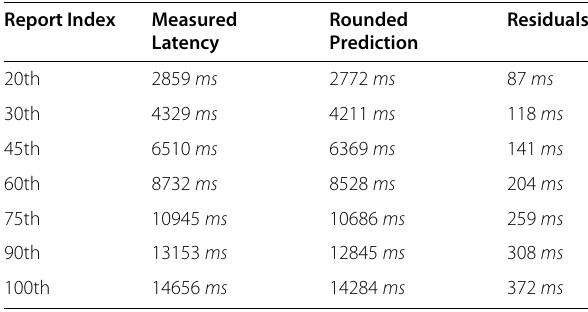
Table 3 Validation of the FIFS Uploading Latency Model by Using New Measurements against Prediction